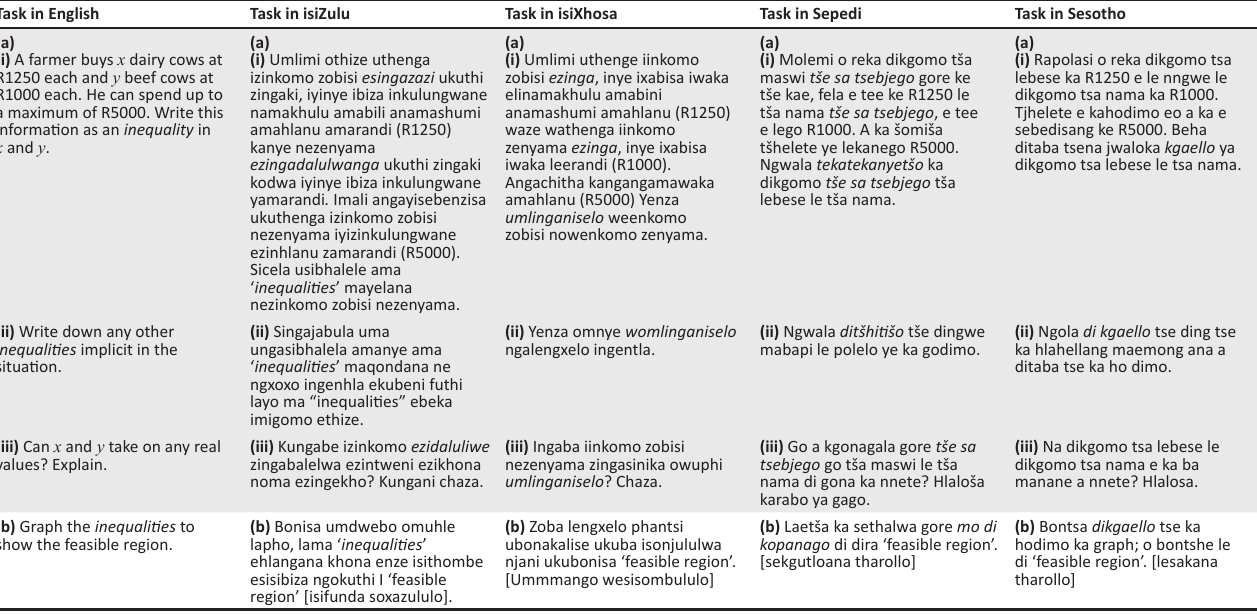
TABLE 1: Mathematics task in original English and translation. Task in